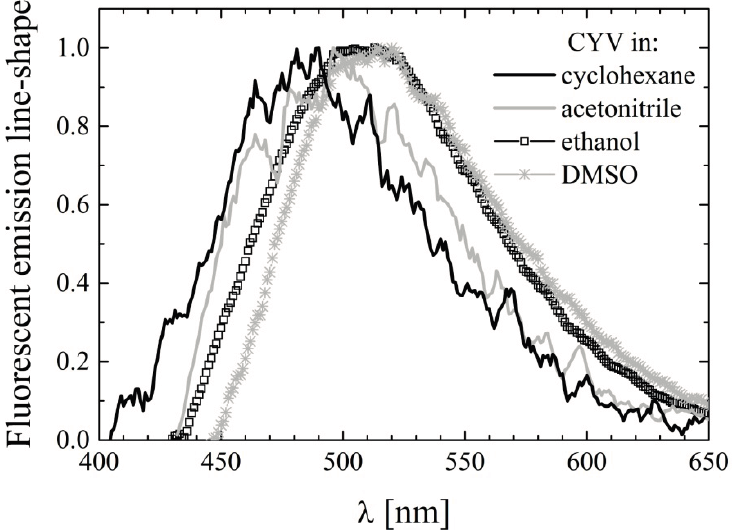
Figure 4. Fluorescence emission spectral line-shapes of CYV in selected solvents: cyclohexane (black line), acetonitrile (gray line), ethanol (squares) and dimethylsulfoxide